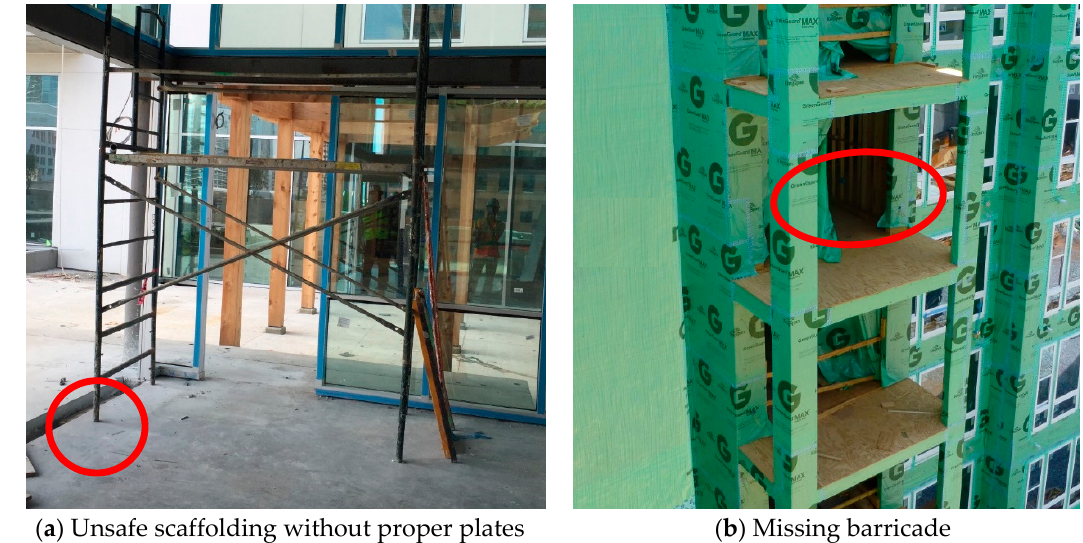
Figure 2. Hazards identified on a specific day for ( a ) a scaffolding hazard and ( b ) a ladder hazard.